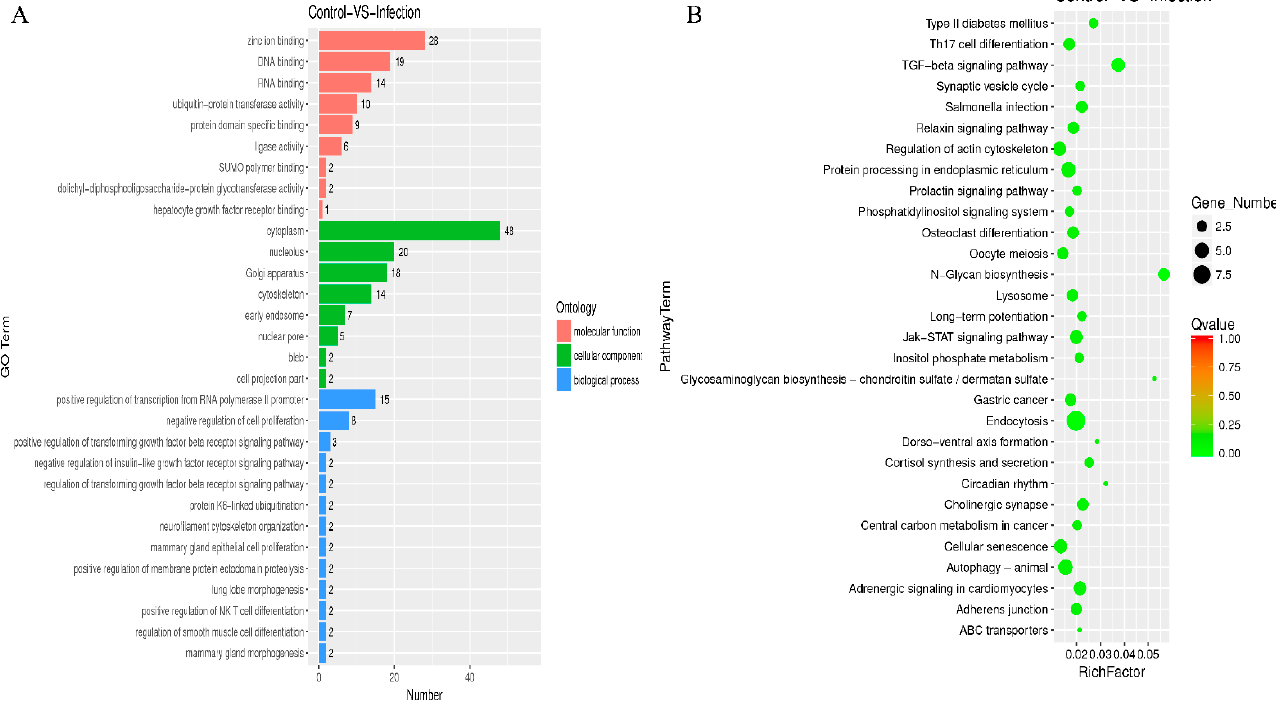
Figure 6. GO and KEGG pathway analysis of circular RNAs in healthy and endometritis mice. ( A ) GO analysis of the main biological roles of circular RNAs. ( B ) KEGG analysis of signaling pathways involved in circular RNAs.